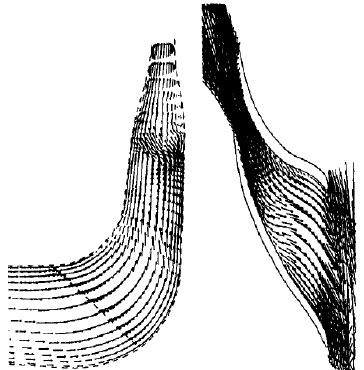
Figure 5. Blade loading specified based on secondary flow control theory and corresponding pressure distribution [43].